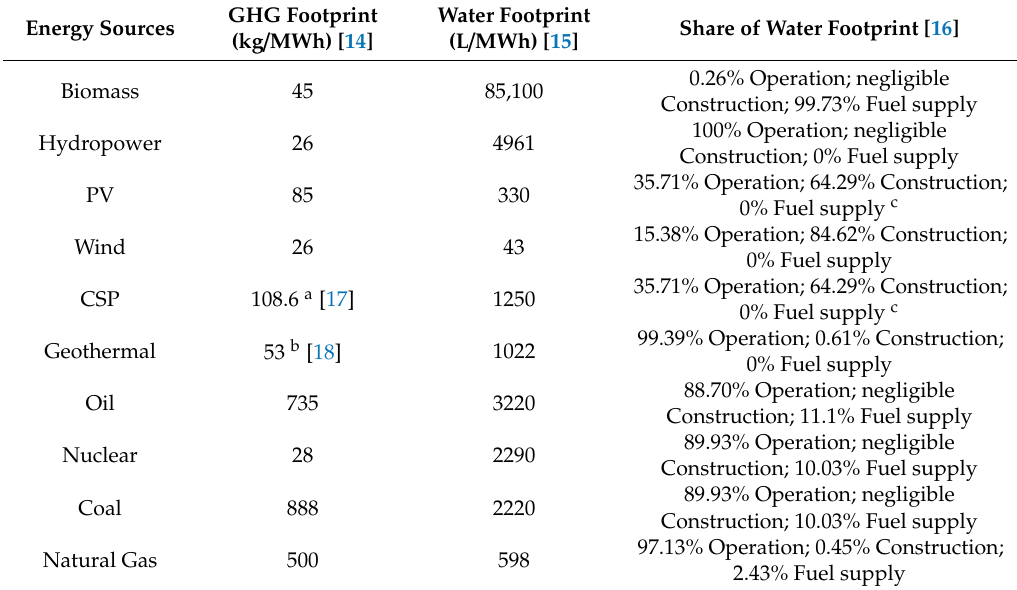
Table 1. The Greenhouse Gas (GHG) and water footprints of di ff erent energy